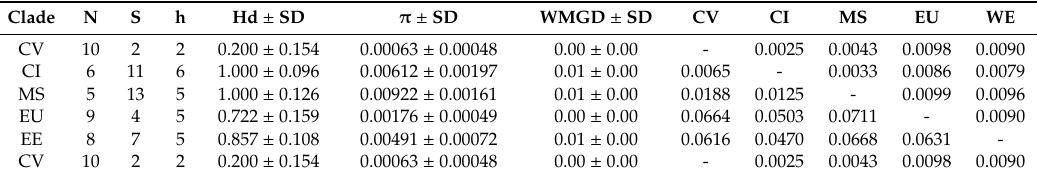
Table 2. Genetic diversity parameters. Values calculated for H. savii cyt b mtDNA sequences for each clade represented in the phylogenetic tree: Cabo Verde (CV), Canary Islands (CI), Morocco and Southern Iberia (MS), Europe (EU), and Eastern Europe (EE). The number of sequences (N), polymorphic sites (S), and haplotypes (h), as well as haplotype (Hd) and nucleotide ( π ) diversity, and within mean group distance (WMGD) with respective standard error (SD) are given. The estimates of evolutionary divergence over sequence pairs between clades are also given. Standard error estimates are shown above the